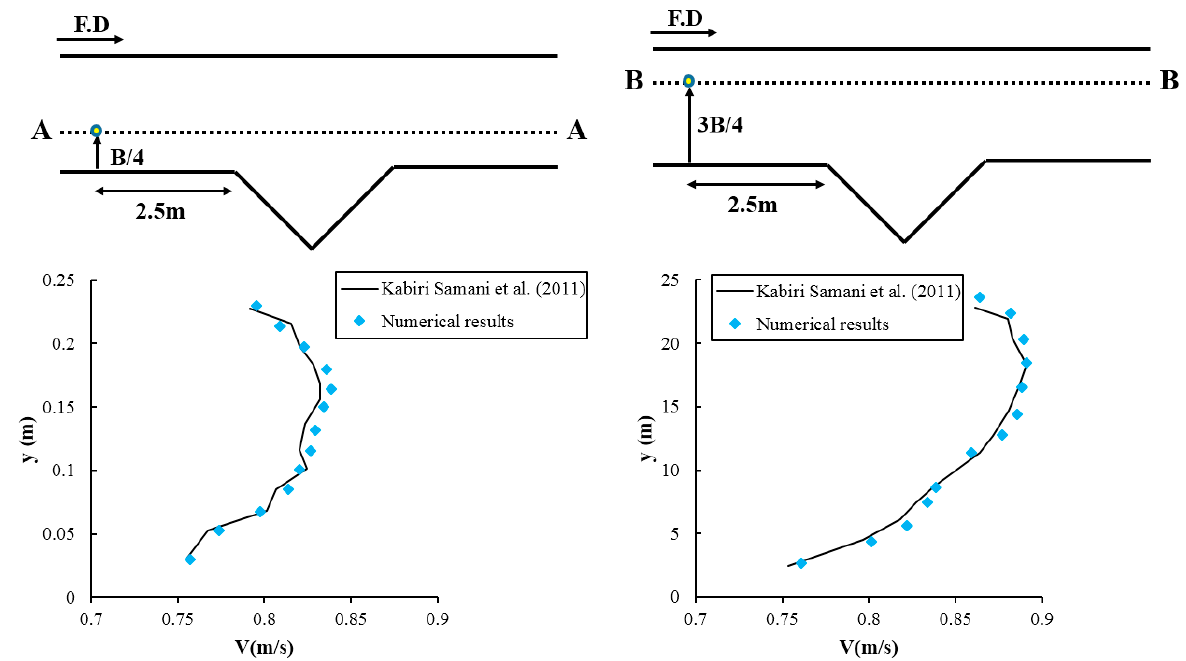
Figure 7. Velocity profiles along the axis ( A-A ) and ( B-B ) the main channel, upstream of the triangular labyrinth side weir.